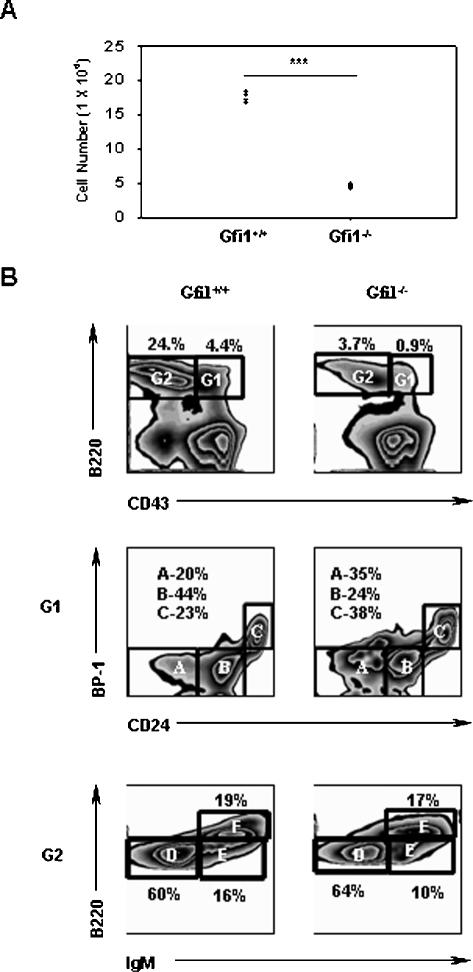
Analysis of bone marrow B cell development in Gfi1−/− mice.A) Absolute numbers of B220+ bone marrow B lineage cells determined from bone marrow of both hind limbs (n = 4 mice). B) FACS plots indicating relative decrease of bone marrow progenitor B cells in Gfi1−/− mice according to the Hardy classification. B220+CD43+ cells were gated (G1) and further analyzed for expression of CD24 and BP-1 (middle panel). B220+CD43− cells were gated (G2) and analysed for expression of B220 and IgM (bottom panel). Flow cytometry was done in pooled cell suspensions (n = 5 mice). Shown is a representative experiment of 5.